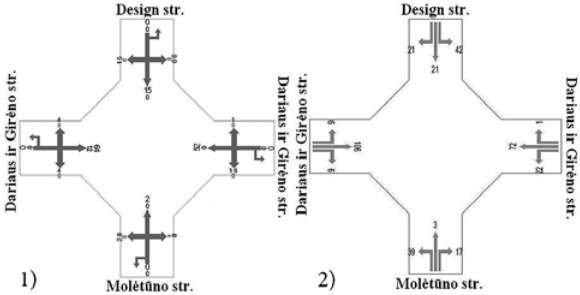
Fig. 4. Traffic volume: 1 – existing; 2 – forecasted